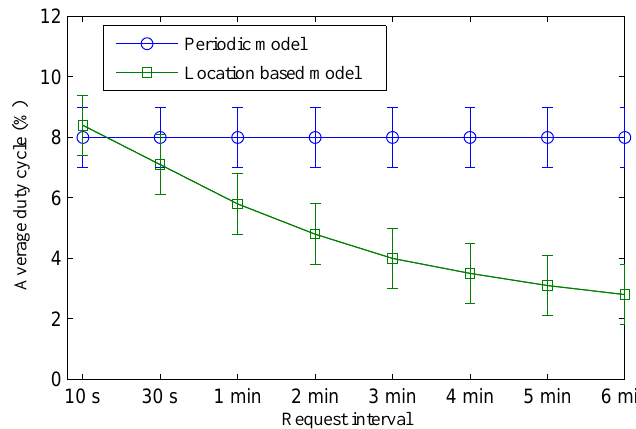
Figure 2. Average energy consumption under various request